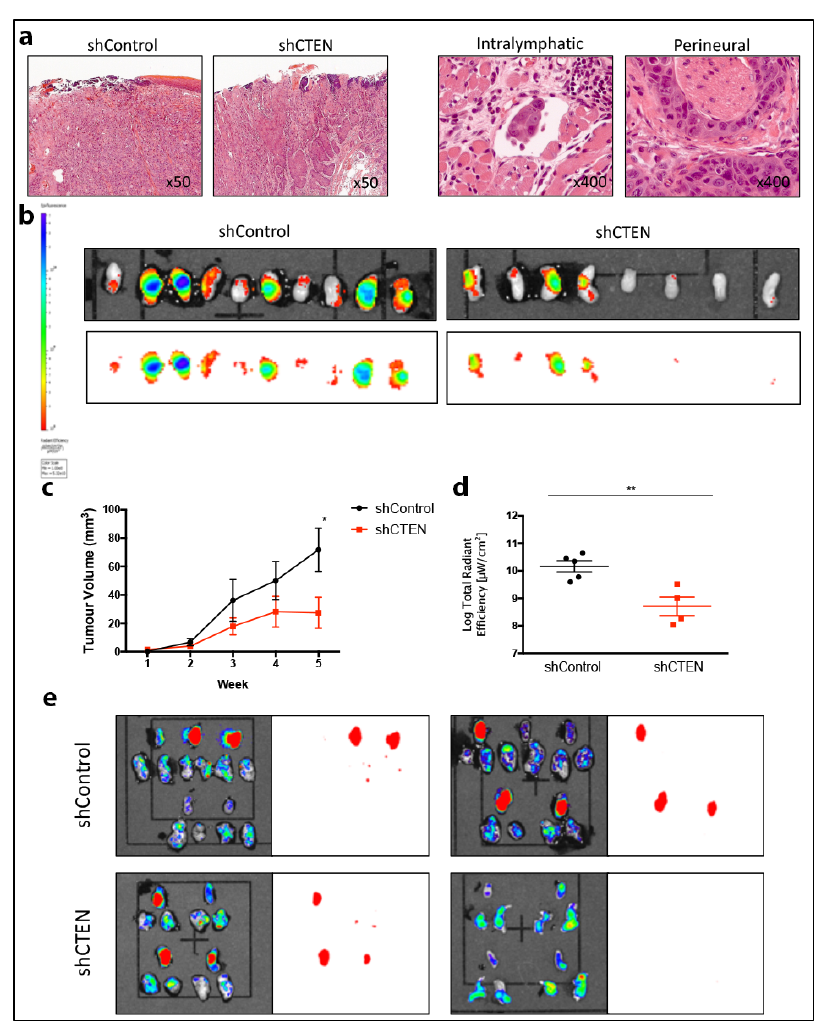
Figure 2. CTEN knockdown reduces tumour growth in an orthotopic mouse model of oral cancer. Xenograft tumours were made by orthotopically injecting shCtrl- or shCTEN-treated SCC25 cells, allowed to grow for 6 weeks with microcalliper measurement weekly and then dissected and pathologically examined. The orthotopic tumours mimicked the pathological appearance of human HNSCC accurately, including other features of aggressive tumour invasion, such as lymphatic and perineural invasion in both the control and CTEN-knockdown tumours ( a ). ( b ) Post-mortem tongue specimens were dissected and imaged on a small animal imager utilising a GFP tag included with the shRNA vectors. These are displayed as a GFP / photo overlay (upper panel) or GFP subtraction image only (bottom panel). Microcalliper tumour volumes ( c ) and automated measured radiant e ffi ciencies ( d ) of tongue tumour samples corroborated a significant tumour growth reduction in CTEN knockdown tumours (Student’s t -test, * p < 0.05, ** p < 0.01). ( e ) Tongue specimens (top specimen in each double row) and bilateral cervical lymph node chains (bottom specimens (two per animal) in each row) were surgically dissected and imaged for GFP expression. The subsequent image overlays then underwent digital image subtraction to identify tumour deposits in the cervical lymph node biopsies. shControl cells resulted in 5 / 10 primary tumours compared with 6 / 10 clinically or image evident tumours in shCTEN cells. However, there were six regional lymph node deposits in shControl versus only three in shCTEN models. Two mouse specimens were not included in the final imaging analysis due to their demise in the week prior to experiment completion. Their results up to the point of death have been included in the growth